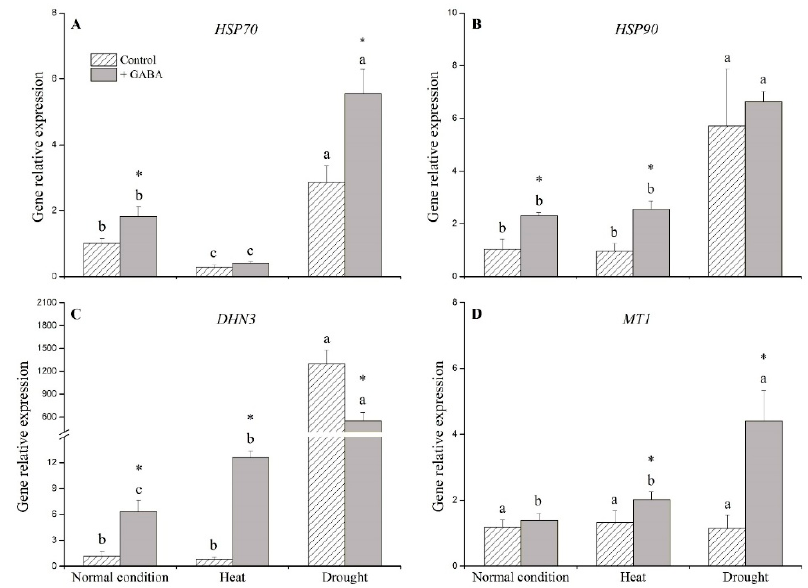
Figure 8. Effects of γ -aminobutyric acid (GABA) on genes’ expression of ( A ) heat shock protein 70 ( HSP70 ), ( B ) heat shock protein 90 ( HSP90 ), ( C ) dehydrin 3 ( DHN3 ), and ( D ) metallothionein 1 ( MT1 ) under normal, heat, and drought conditions. Vertical bars indicate ±SE of mean ( n = 4). Different letters above columns indicate significant differences for one particular treatment (control or +GABA) under different conditions; asterisk “*” indicates significant difference between control and +GABA treatment under a given condition.